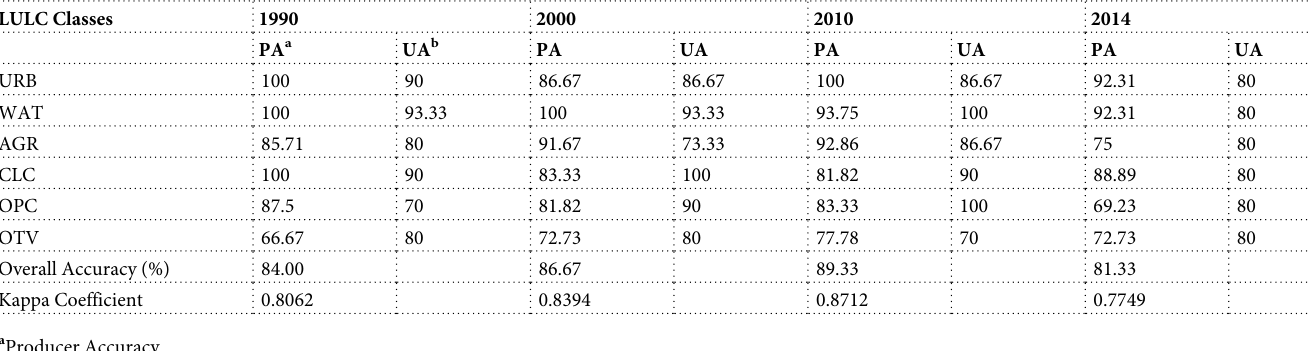
Table 3. Classification accuracy values for LULC maps (%).